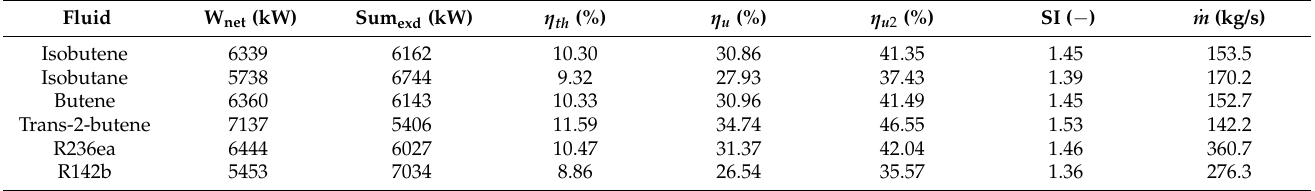
Table 7. Optimized model for different working fluids for 8 ◦ C pinch point for the regenerative ORC model.